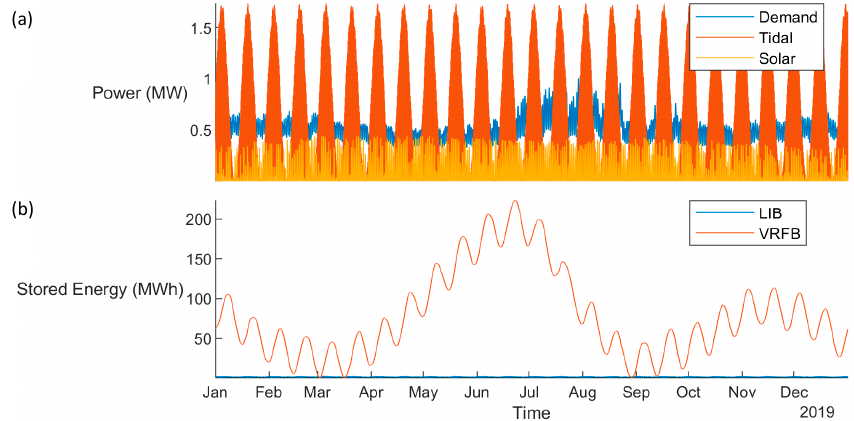
Figure 5. The simulated solar and tidal power generation and the power demand are shown in subplot ( a ). The energy stored in the LIB and VRFB for each hour of the year for the optimal baseline-cost microgrid with tidal and solar RES are shown in ( b ).